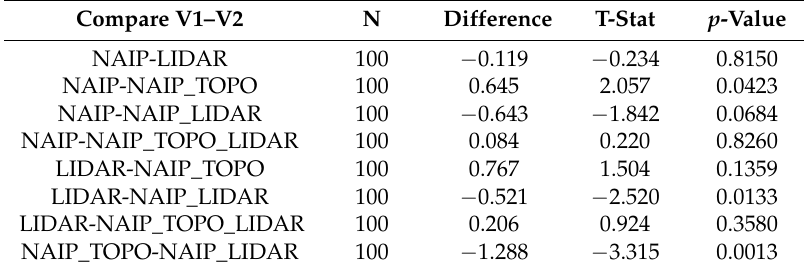
Table A2. BAWD paired stand comparisons between models developed from combinations of NAIP, LiDAR, and Topo data sources.